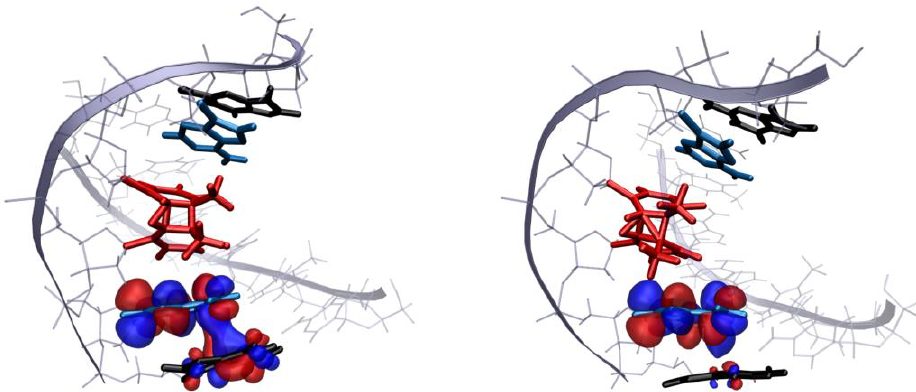
Fig. 1 . Oligonucleotide containing the CPD lesion (two covalently bound thymines, red), framed by two adenine (light blue) guanine (black) sequences and with the complementary strand. This structure was used experimentally [3], as well as for our theoretical calculations. In the left geometry, there is an orbital overlap between guanine and adenine indicating exciplex formation, while the right geometry shows no overlap of any